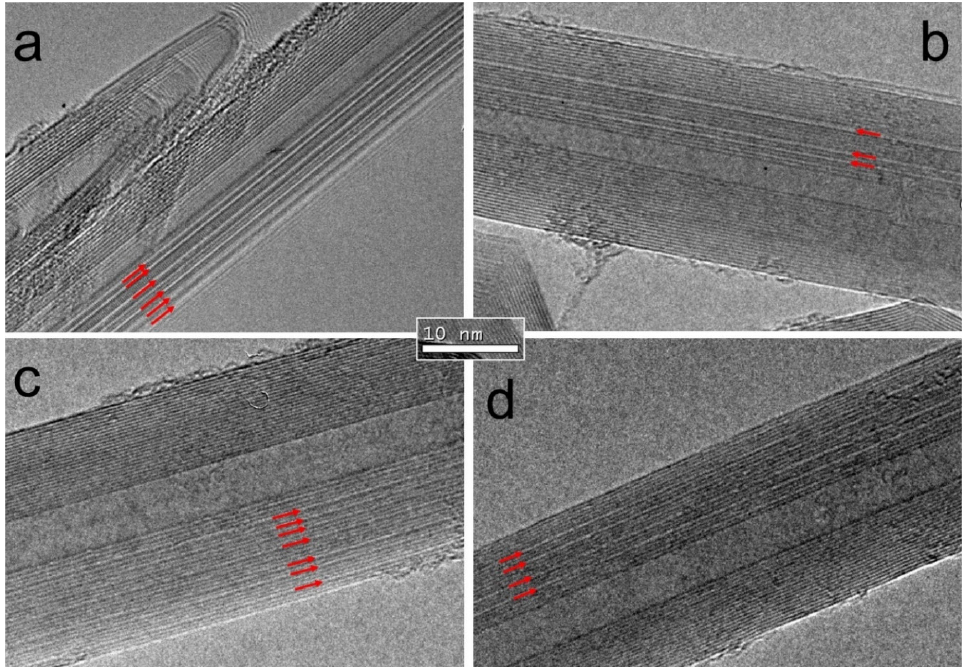
Figure 6. Examples of anomalous intergraphene distances (labelled with arrows) in the as-received, arc-prepared MWCNTs: ( a , b ) from Sigma Aldrich; ( c , d ) from MER Corporation. It is striking that they are systematically one-sided.